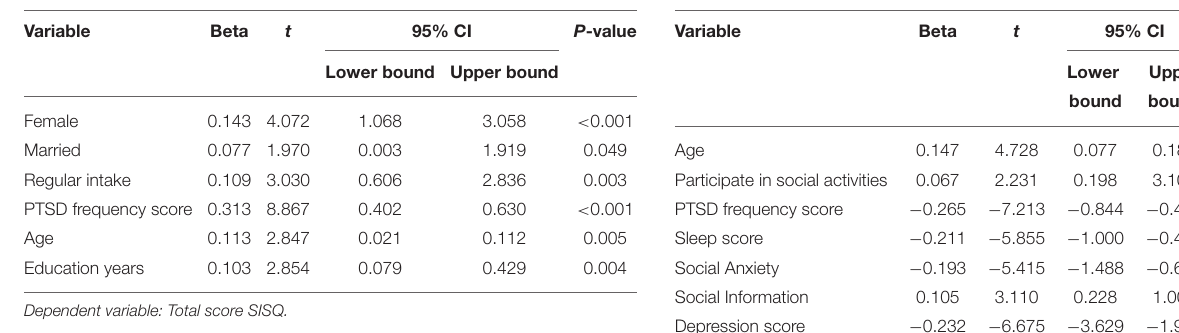
TABLE 4 | Multiple linear regression for possible related factors of MCS value of